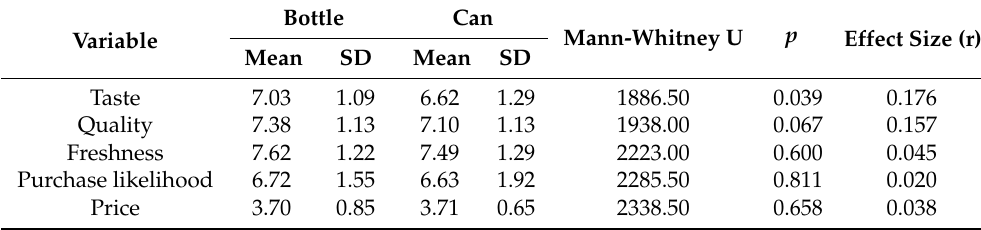
Table 3. Mann-Whitney tests. Significant terms highlighted in